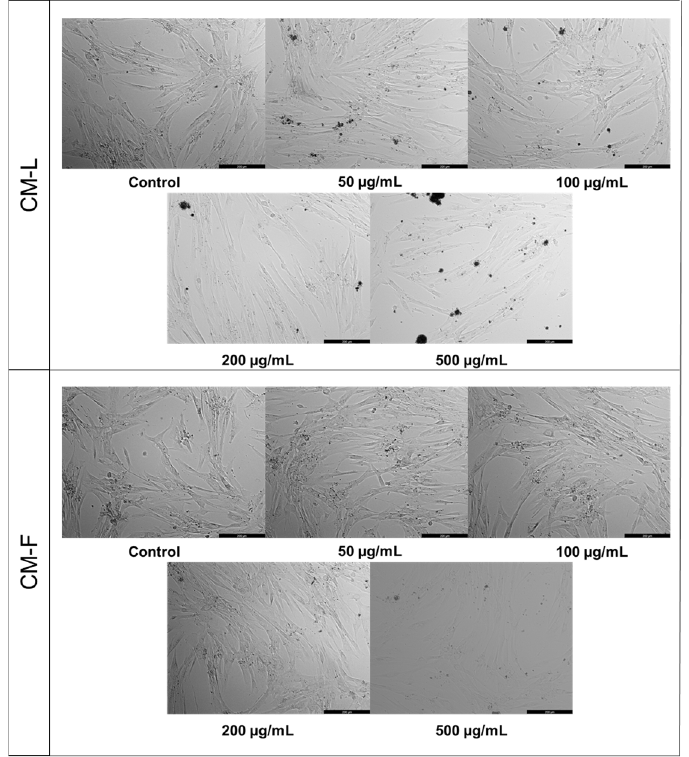
Figure 2. Morphological evaluation of MRC-5 cells after 48 h of treatment with Cladanthus mixtus extracts. Results are representative of three independent experiments. Scale bar: 200 µm.